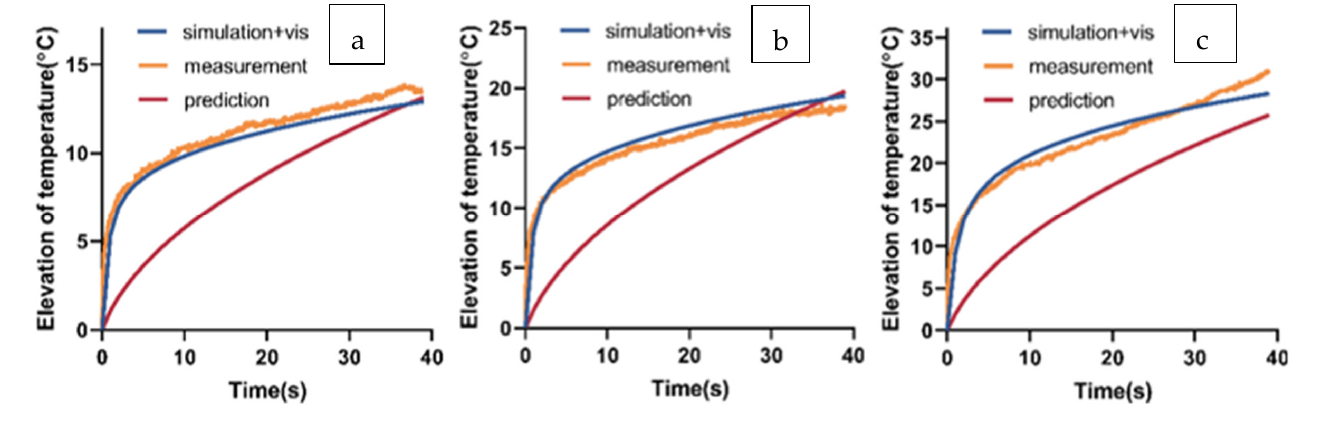
Figure 5. Temperature elevations at focus ( a ) 4 W, ( b ) 6 W, and ( c ) 8 W. The yellow solid lines present the measured temperature (measurement). The blue solid lines present the simulated temperature considering viscous heating (simulation + vis). The red solid lines present the predicted temperature (without glass and without VH) in the pure bovine liver (prediction).